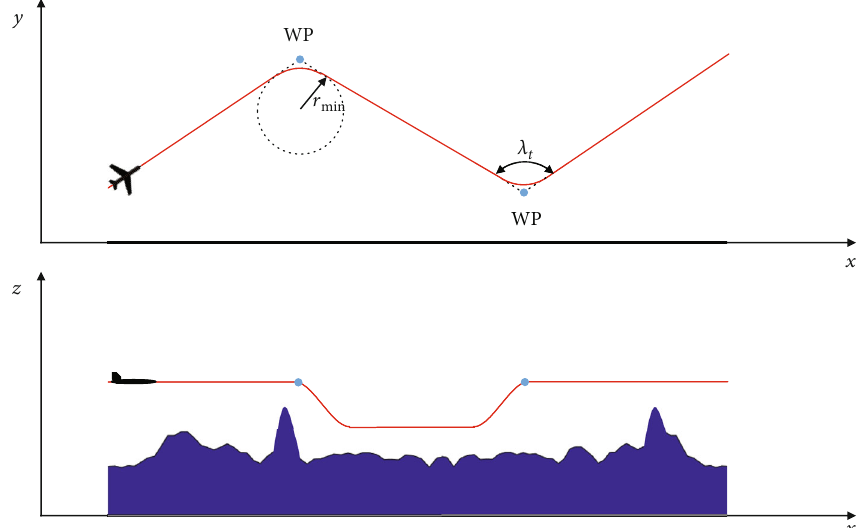
Figure 1: Coordinates, path, and dynamic constraints of UAV. WP denotes the waypoint. r the turning angle, respectively.